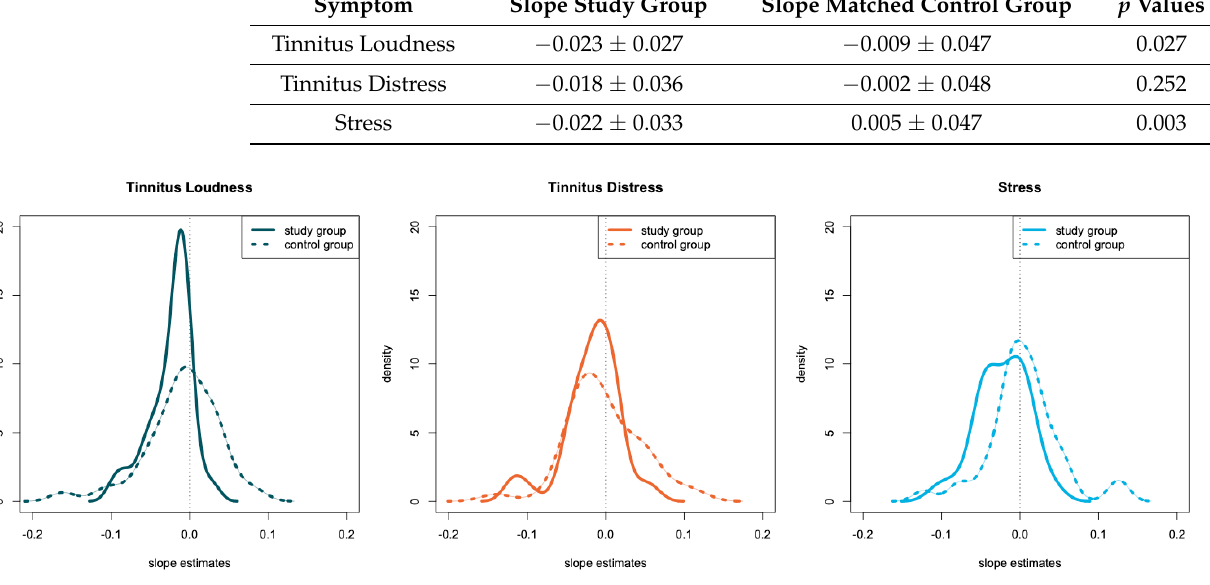
Figure 3. Visualization of the linear estimates of the study group and the matched control group. Estimates are shown for tinnitus loudness, tinnitus distress, and stress. Only the estimates of the statistically significant regressions are shown.